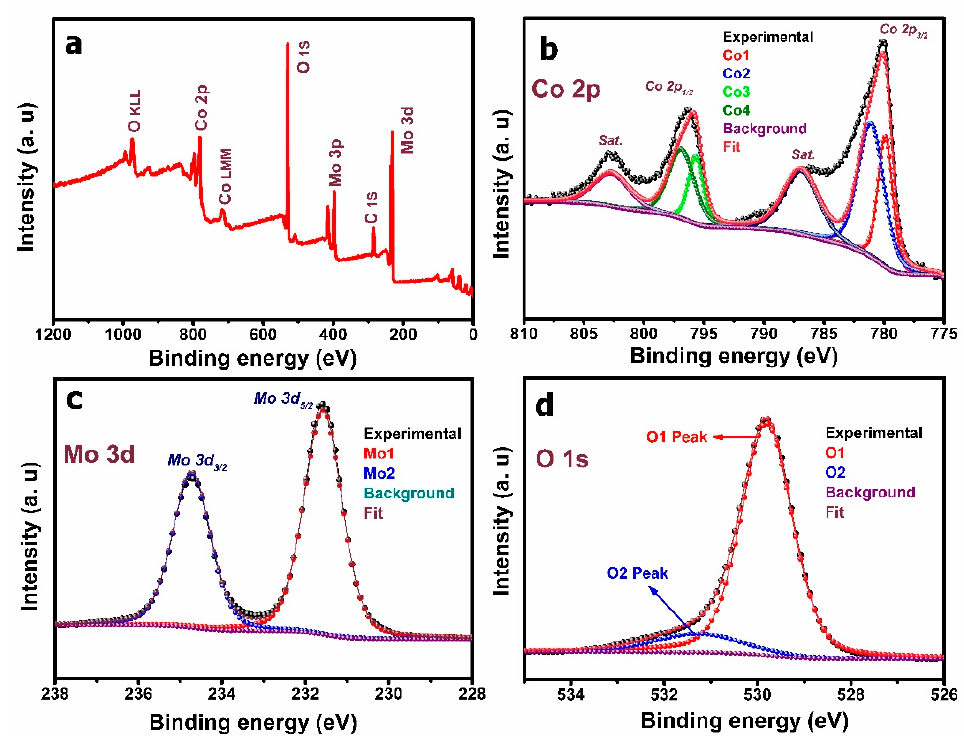
Figure 4. ( a ) XPS survey scan spectrum, core level spectra of ( b ) Co 2 p , ( c ) Mo 3 d and ( d ) O 1 s for R-CMO catalyst.